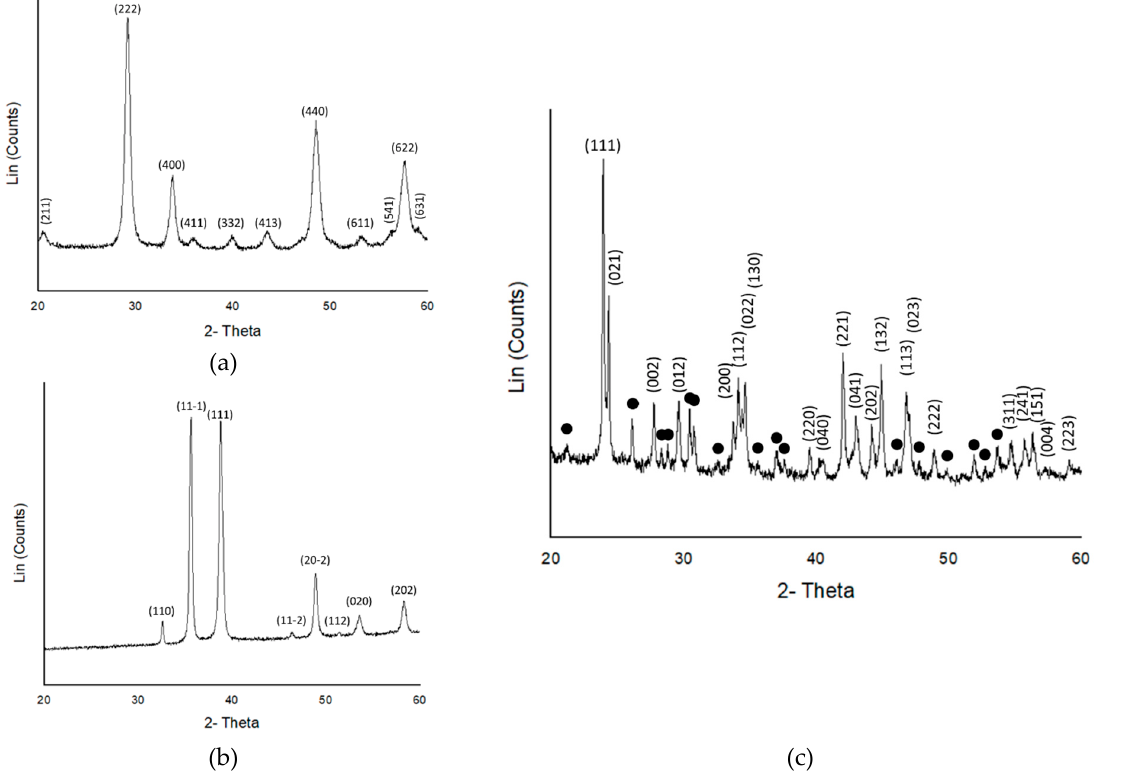
Figure 4. Powder X-ray diffraction patterns of ( a ) yttrium oxide, ( b ) copper oxide, and ( c ) barium carbonate and barium silicate ( • ). All the reactions were carried out using their respective metal nitrates, calcined in new crucibles, and a maximum temperature of 620 °C.